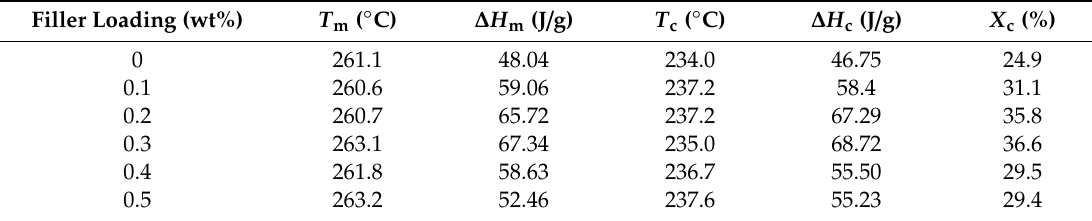
Table 2. DSC data of pure PA66 and EG/PA66 composites.